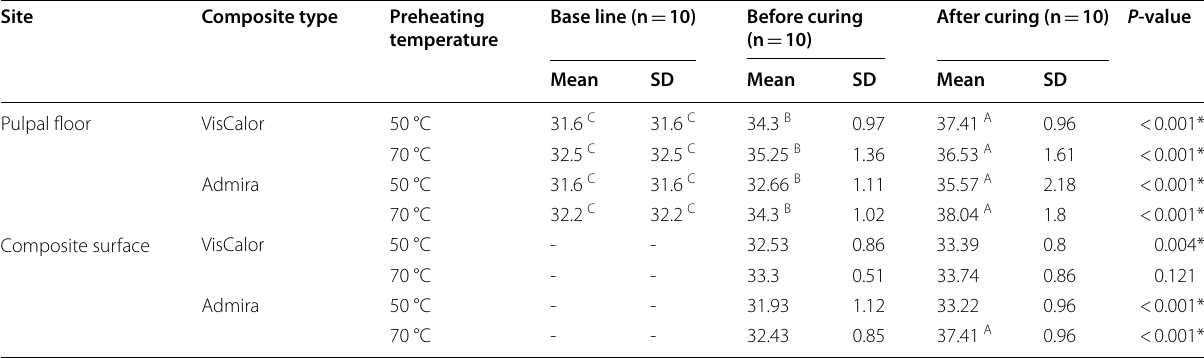
*Significant at P 0.05, Different superscripts in the same row indicate significant difference ≤